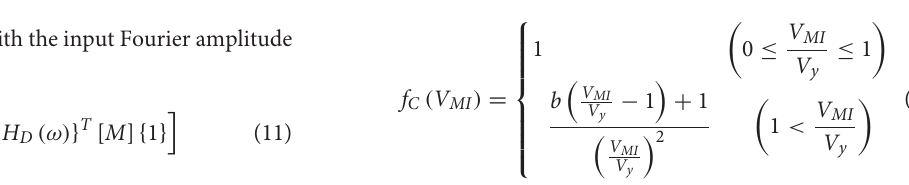
domain after the multiplication with the input Fourier